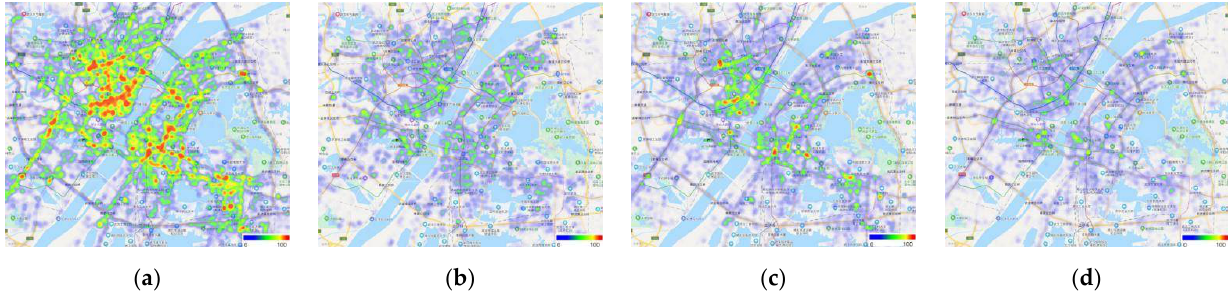
Figure 11. The change of population heat in the central urban areas in 2019 and 2020 (( a ) before the Wuhan lockdown (20 January 2020); ( b ) after the Wuhan lockdown (25 January 2020); ( c ) the heat map of 31 January 2019; ( d ) the heat map of 5 February